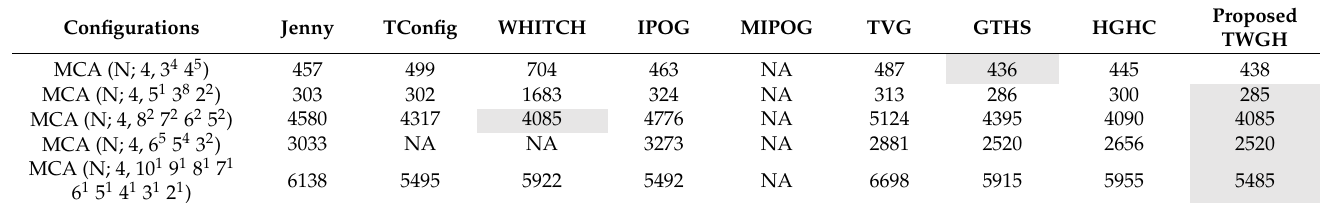
Table 6. Five system configurations with mixed variables.